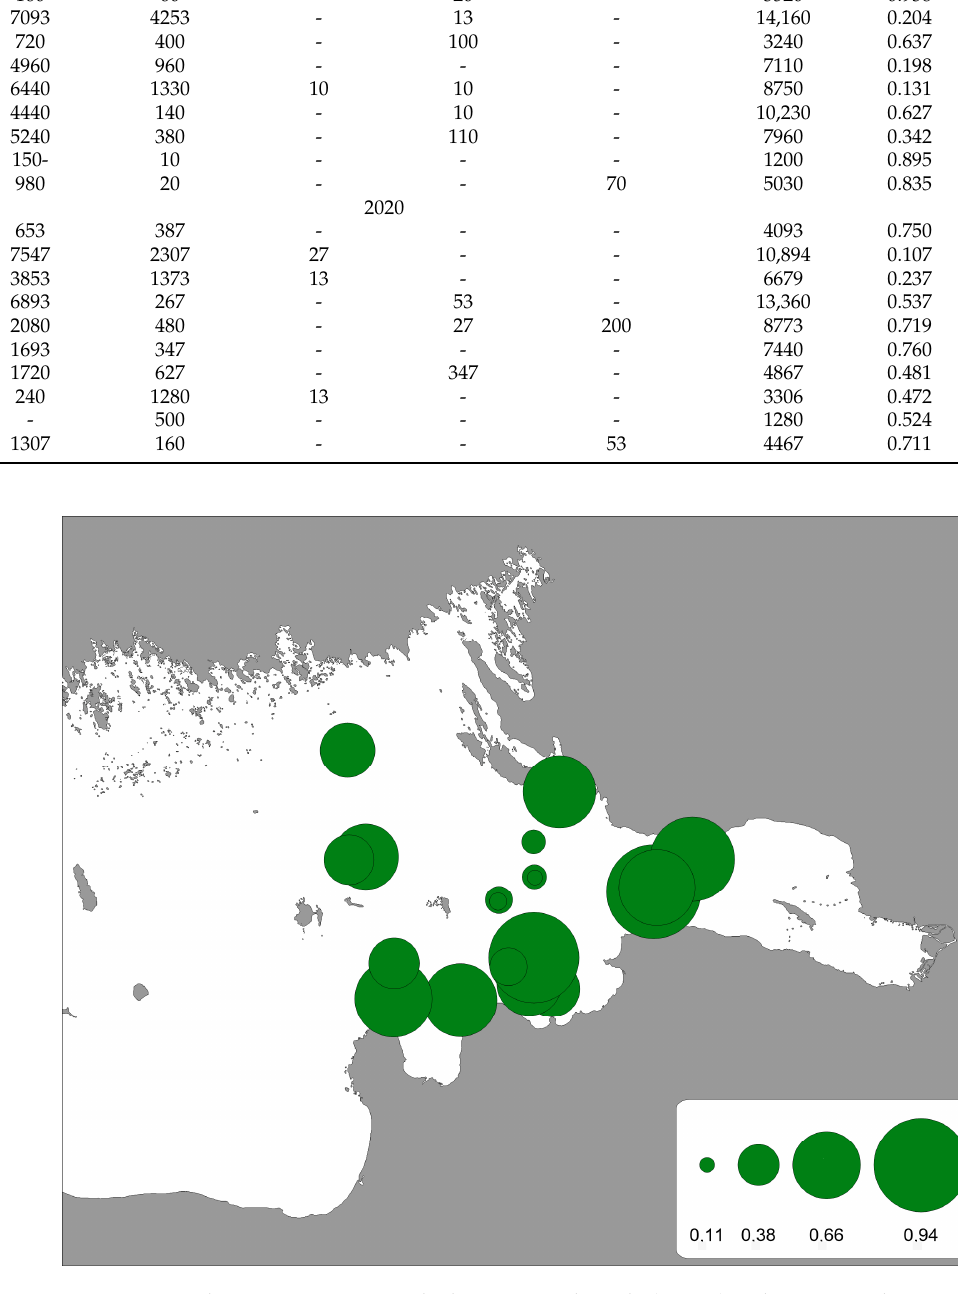
Figure 4. Benthic Opportunistic Polychaetes Amphipods (BOPA) index at sampling sites in the eastern Gulf of Finland.